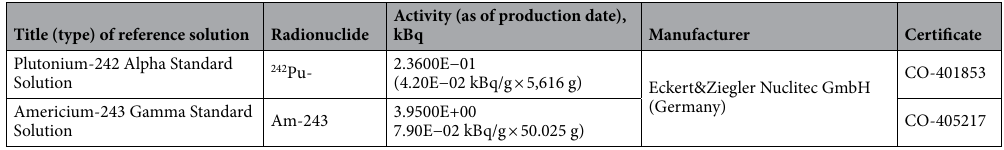
Title (type) of reference solution Radionuclide